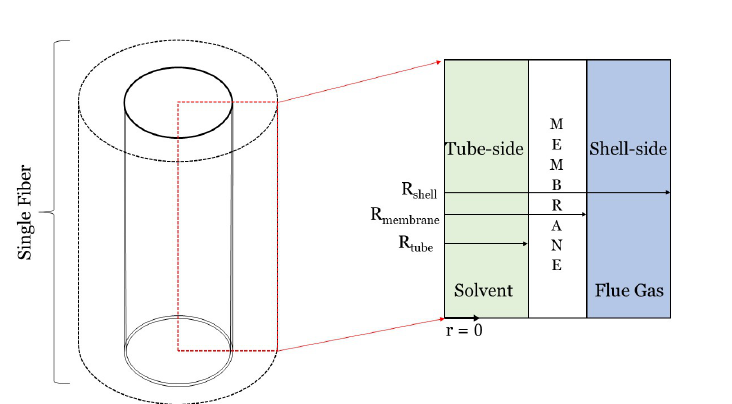
Figure 2. Graphic of the one-dimensional modeling framework for a gas-liquid HFMC. The radial dimension is the one dimension of interest; variations in the axial and angular dimensions are not taken into account. Liquid solvent flows through the inside or ”tube-side” of the fiber, while flue gas flows outside or on the ”shell-side” of the fiber.